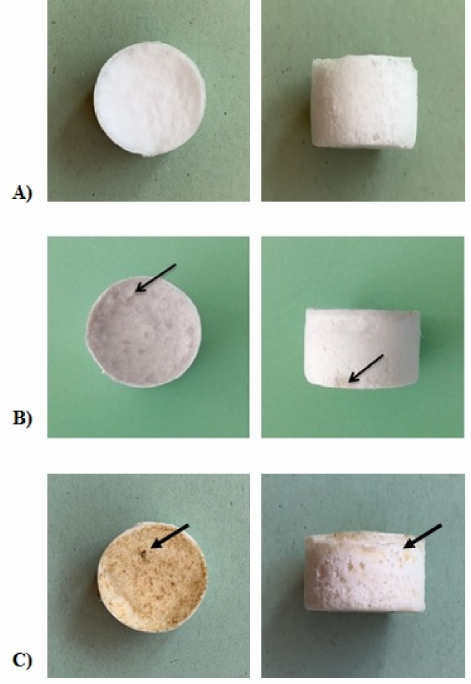
Figure 3. Representative images of PCL-based scaffolds. In detail, BCP/PCL samples with NaCl ( A ); Ag-functionalized, BCP/PCL + Ag samples with NaCl ( B ) and NaNO 3 ( C ). The Ag-added samples are visibly darker in the images, and the arrows indicate darker spots in which the Ag has formed agglomerations.